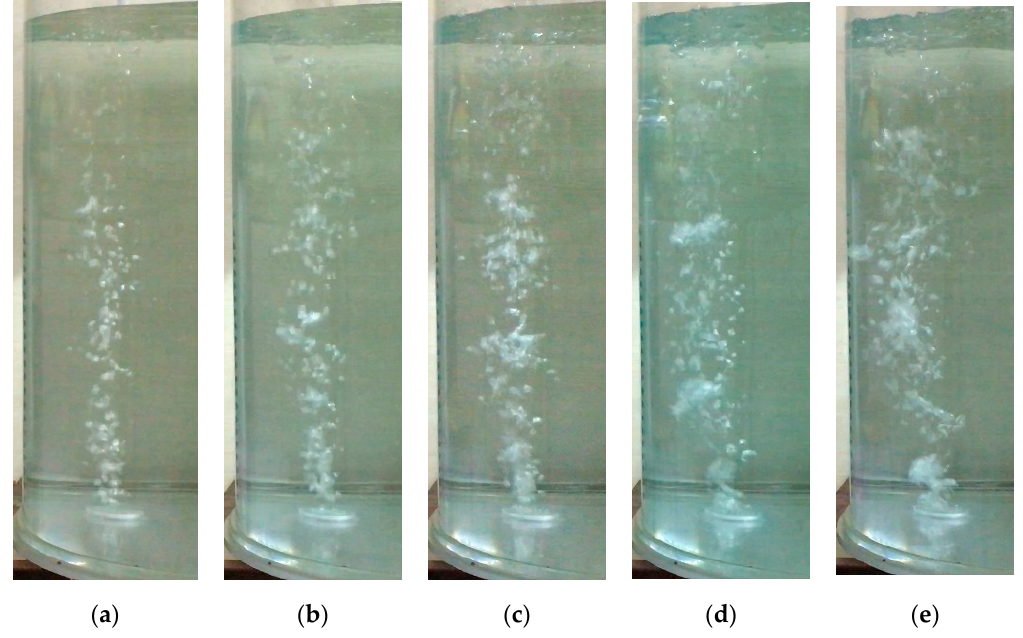
Figure 10. The bubble motion in the water model: ( a ) Q = 0.0475 m 3 /h; ( b ) Q = 0.095 m 3 /h; ( c ) Q = 0.143 m 3 /h; ( d ) Q = 0.191 m 3 /h; ( e ) Q = 0.238 m 3 /h.